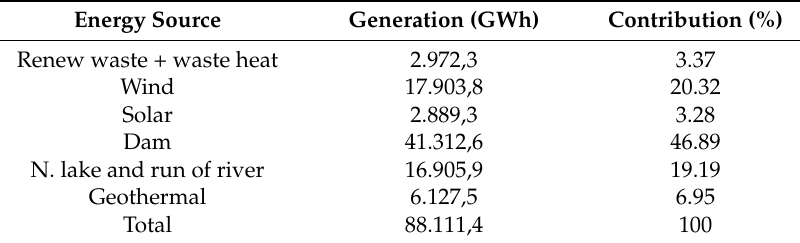
Table 3. Power generation by energy sources in Turkey (2017)